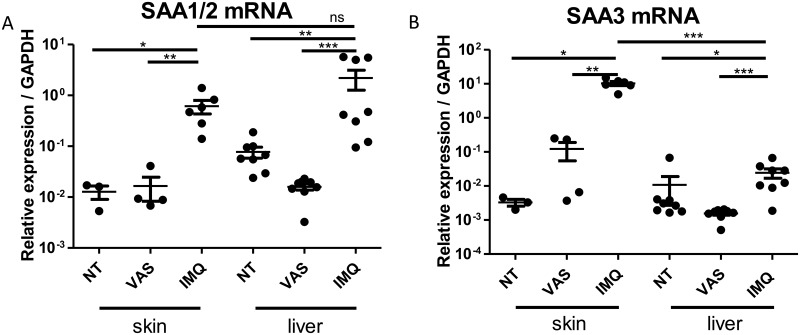
Skin and liver expression of A-SAA in a mouse model of psoriasiform dermatitis.C57BL/6 mice were treated daily during six days with imiquimod 5% cream (IMQ), with Vaseline (VAS) or were not treated (NT). (A) SAA1/2 and (B) SAA3 mRNA expression was determined by RT-qPCR. All data represent mean ± SEM relative expression to GAPDH. Statistical comparisons were performed using t test (*p<0.05; **p<0.01; ns, non-significant).